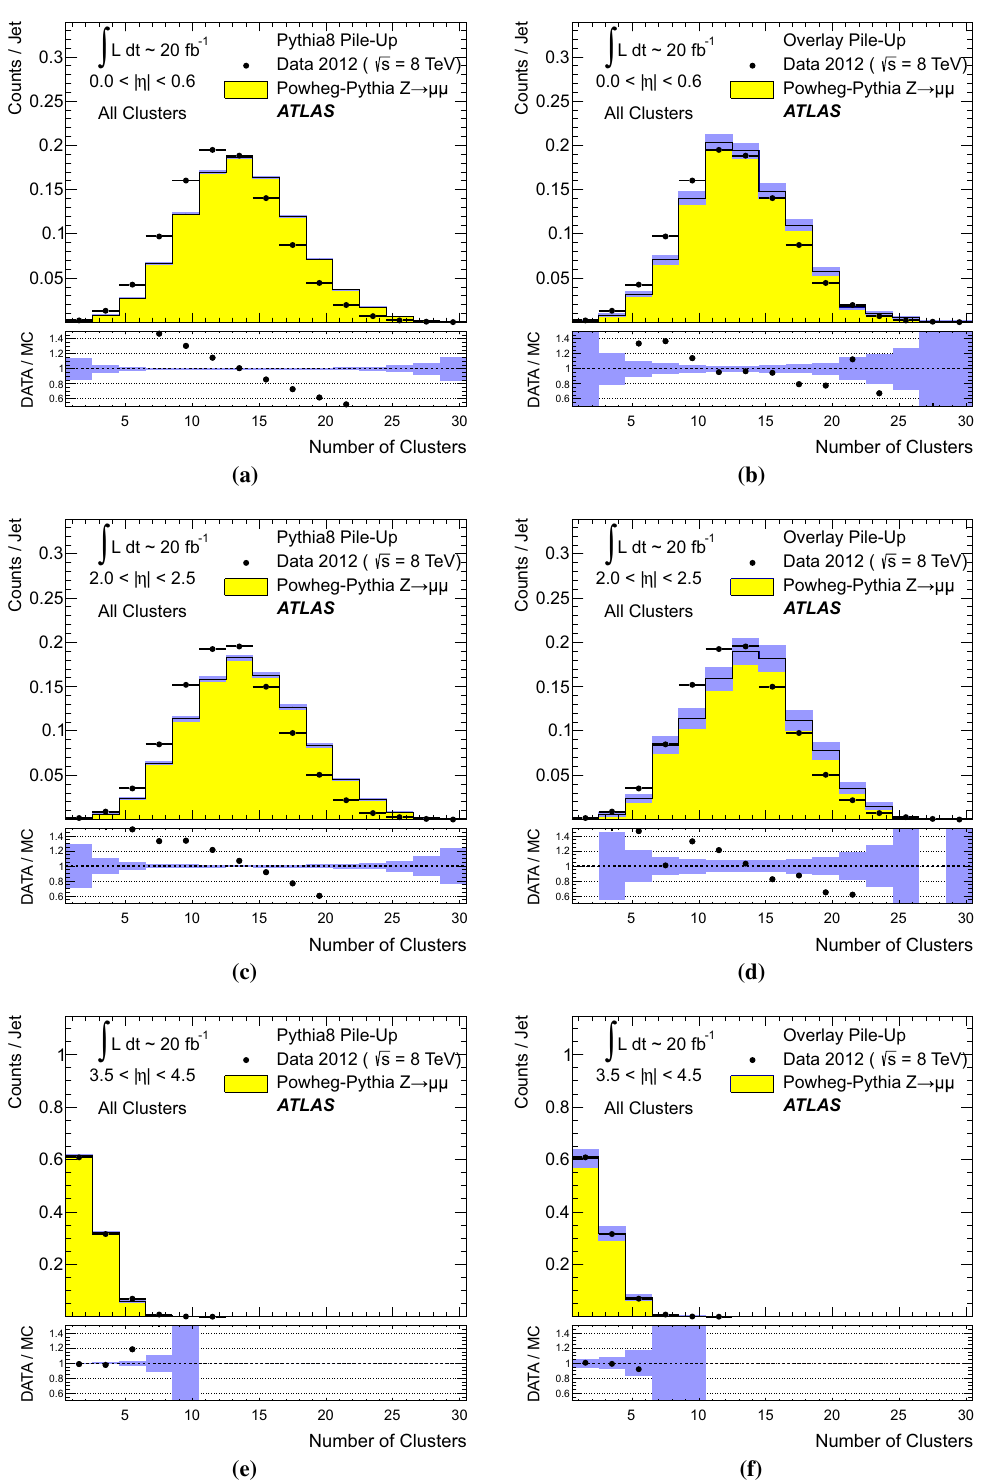
Fig. 31 The distribution of the number of topo-clusters inside anti- k t jets formed with R = 0 . 4 in the ( a , b ) central ( | η | < 0 . 6), the ( c , d ) end-cap (2 . 0 < | η | < 2 . 5), and the ( e , f ) forward detector region (3 . 5 < | η | < 4 . 5) of ATLAS. Shown are results from the analysis of Z → μμ events with at least one jet with 30GeV < p T < 40GeV in 2012 data and MC simulations with fully simulated pile-up in a , c